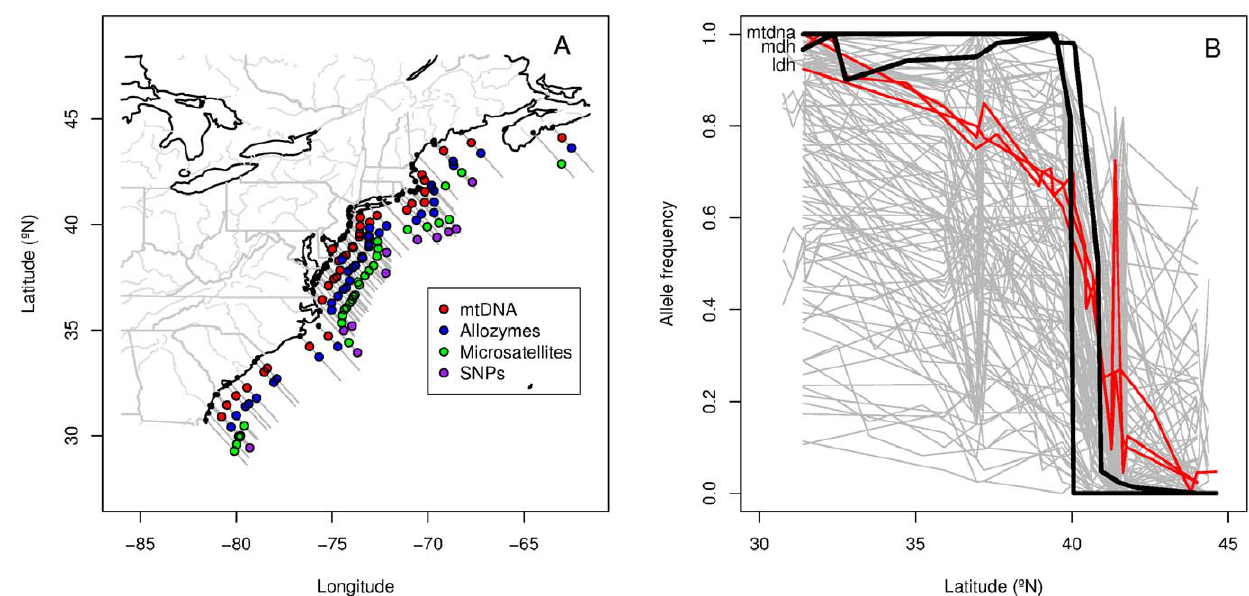
Figure 1. Sampling locations and allele frequencies in Fundulusheteroclitus . A) Location of sampled populations. B) Allele frequences of clinal loci used in the Genomic Co-Co plot analysis. mtDNA and Mdh allozyme clines are highlighted in black, and Ldh allozyme and Ldh SNP clines are highlighted in red.